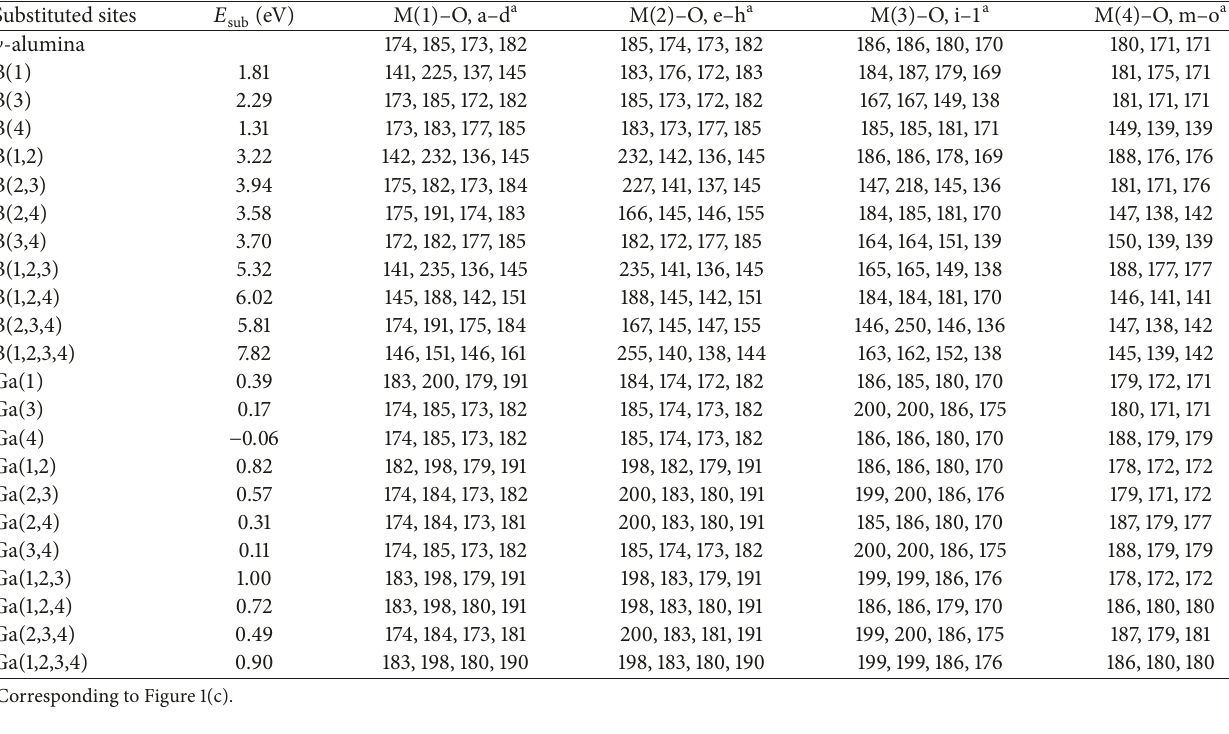
Table 1: Substitution energies ( 𝐸 ) and the M–O bonds distances (pm) of the surface layer atoms before and after substitution for B and sub Gain 𝛾 -alumina (110) surface.